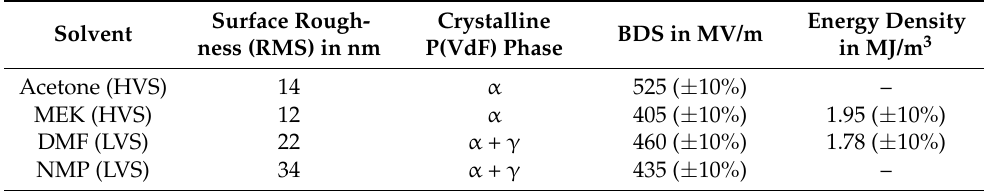
Table 3. Properties of different solvents used for the fabrication of the polymer films. Values for boiling point, vapor pressure, and density are taken from the manufacturer’s